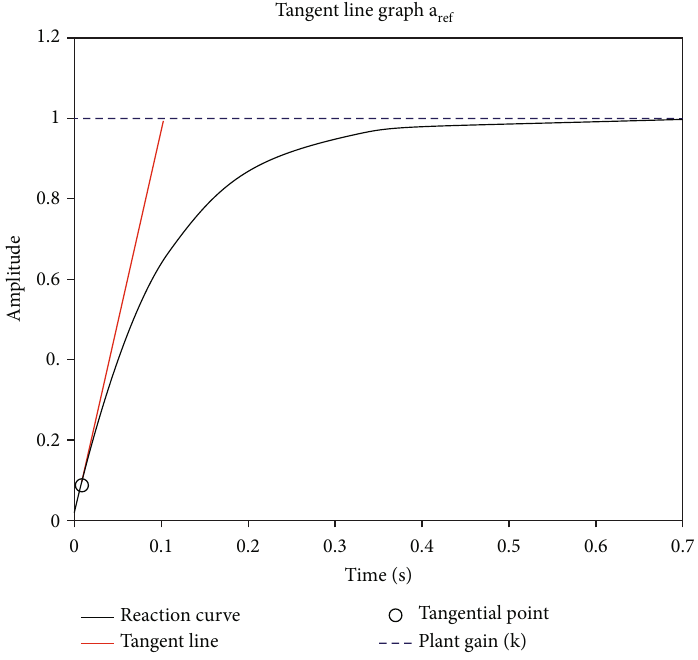
Figure 19: Reaction curve or a